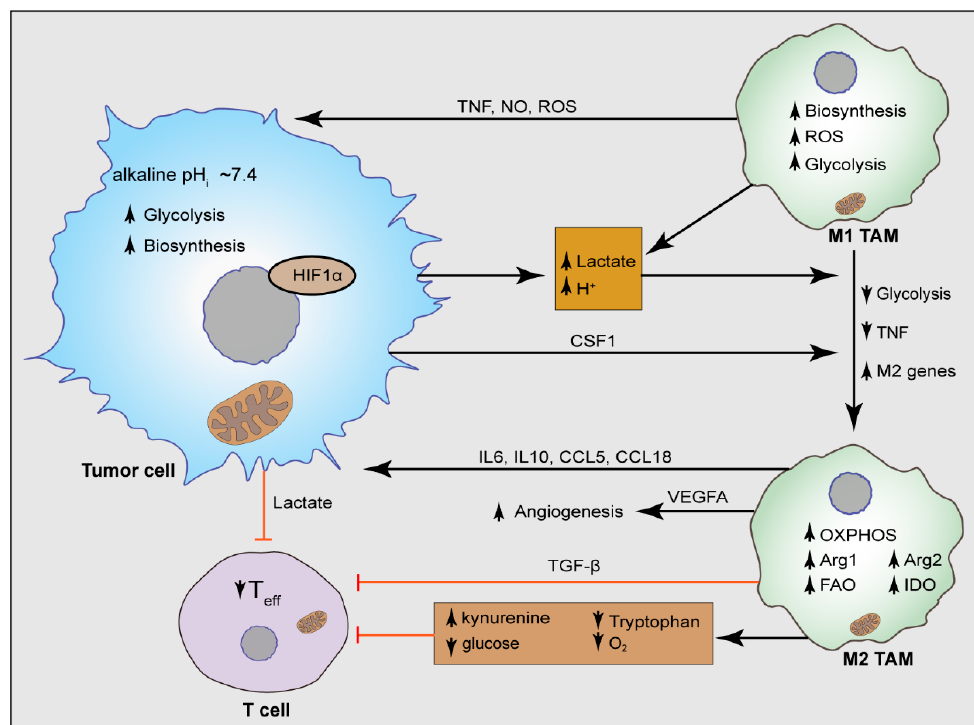
Figure 1. Metabolic crosstalk between TAMs and TME. Highly proliferative cancer cells use aerobic glycolysis and consume an elevated amount of glucose for bioenergetic and biosynthetic purposes, releasing lactate and H + in the TME and able to release elevated CSF1. Lactate, H + , and CSF1 favor the polarization of M1 TAMs to immunosuppressive M2 macrophages which are characterized by the release of metabolic modulators, and immunosuppressive molecules that foster disease progression, including vascular endothelial growth factor A (VEGFA), tumor necrosis factor (TNF), C-C motif chemokine ligand 5 (CCL5), CCL18, interleukin 6 (IL6), and IL10. Moreover, lactate and glucose deprivation exerts immunosuppressive effects on effector T (T eff ) cells. M2 TAMs synthesize abundant levels of arginase 1 (ARG1), ARG2, and indoleamine 2,3-dioxygenase 1 (IDO1), changing the metabolic landscape of the TME and secretes TGF- β which reduces effector T cell function. TNF, tumor necrosis factor; NO, nitric oxide; ARG1, arginase 1; ROS, reactive oxygen species.